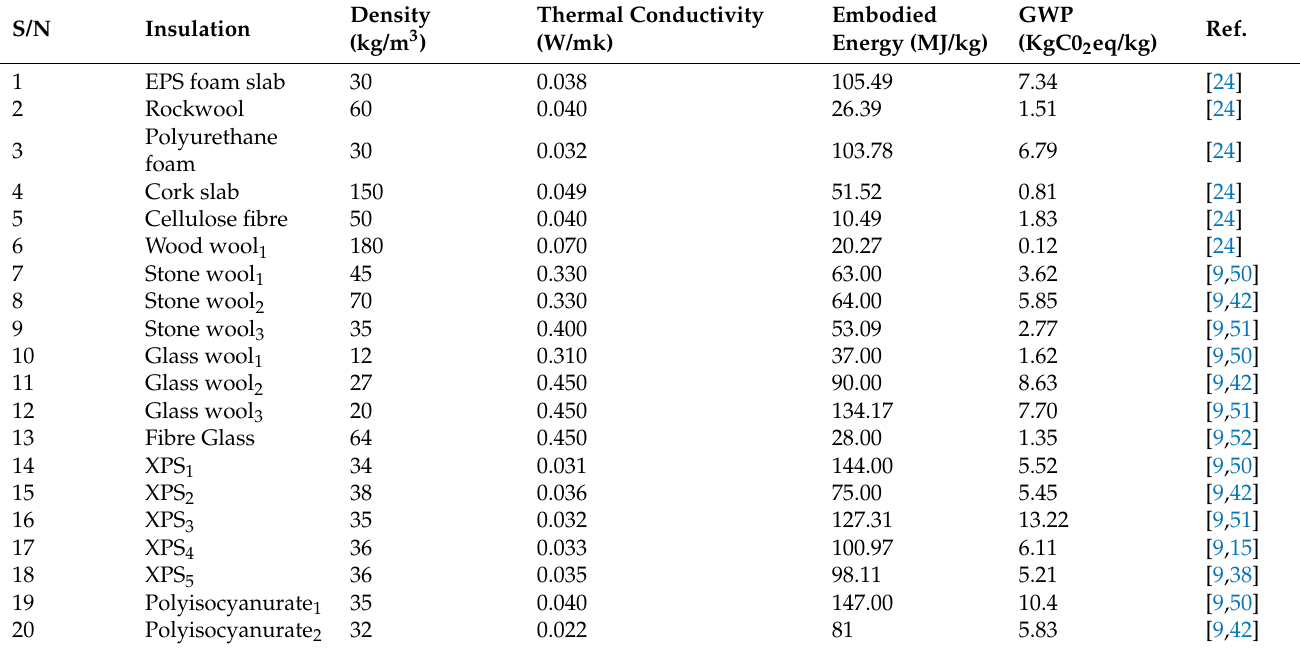
Table 1. Dataset of the thermal Insulation